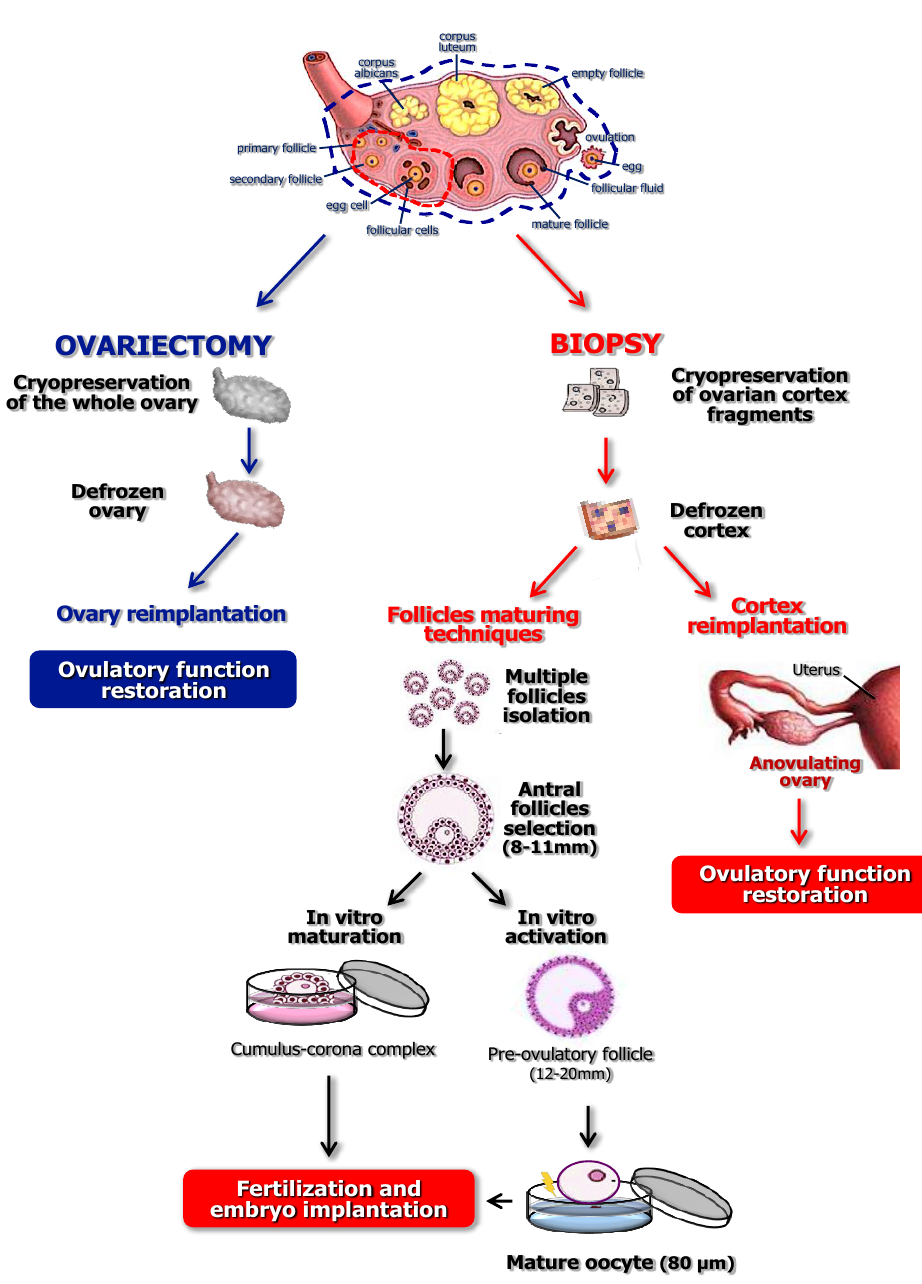
Figure 2. Potential applications of whole ovary and cortex fragments cryopreservation and transplantation for fertility preservation.